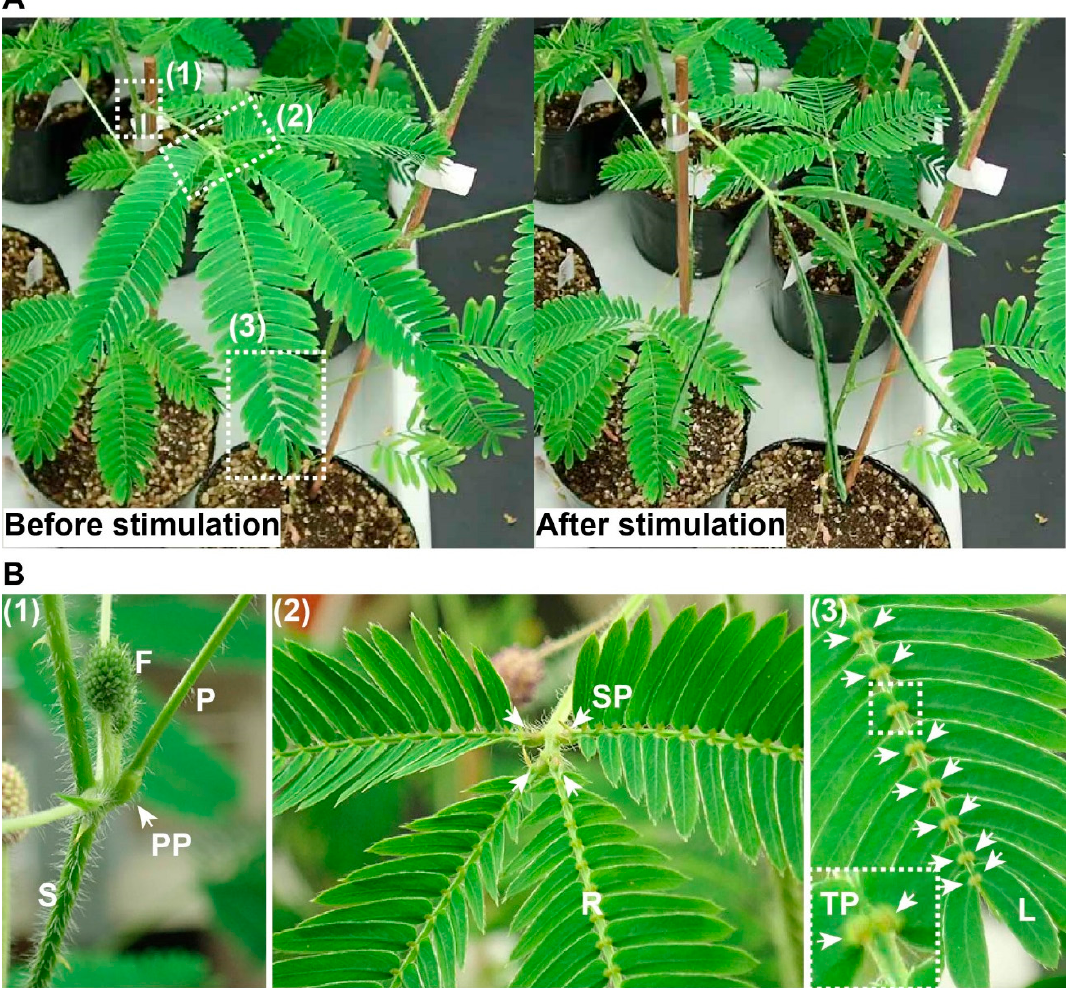
Figure 1. Rapid movement characteristics in M. pudica . ( A ) The leaf of M. pudica , shown expanded before mechanical stimulation (left panel) and folded after the stimulation (touched by hand, right panel). ( B ) The motor organs pulvini. (1) Primary pulvinus (PP, white arrow). S, stem; F, floral bud; P, petiole. (2) Secondary pulvini (SP, white arrows). R, rachilla (the central axis of the pinna). (3) Tertiary pulvini (TP, white arrows). The inset shows a magnified image of pairs of tertiary pulvini enclosed by the dashed line in (3). L, leaflet. The numbers in each panel correspond to those shown in (A).